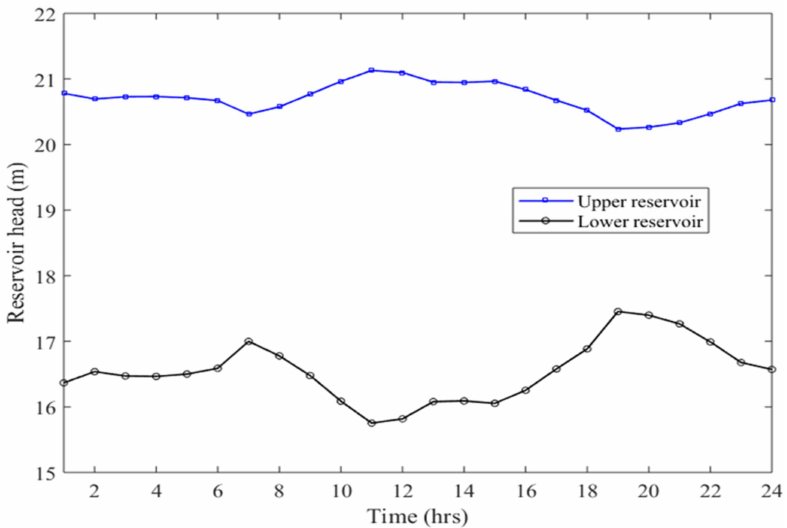
Figure 13. Variable head water level in upper and lower reservoir for entire scheduling